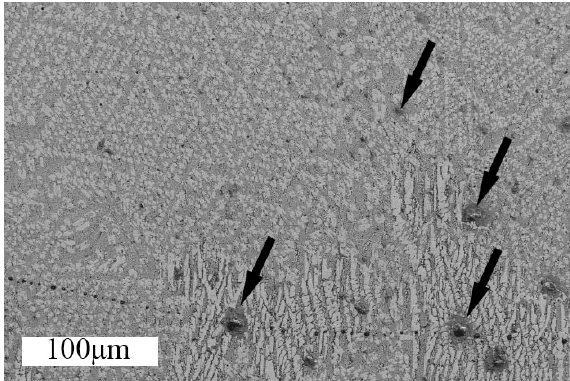
Figure 4. SEM images of black points in Coating 2.